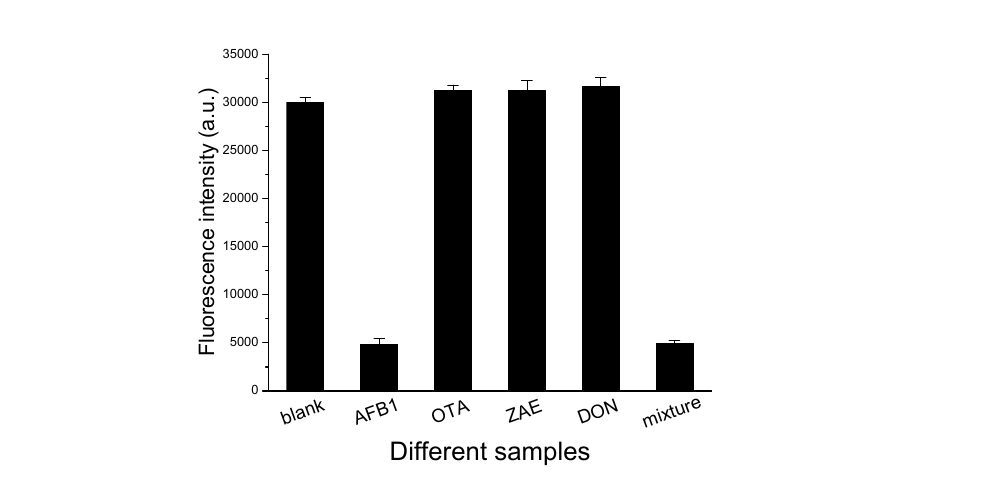
Figure 4. Fluorescence intensities corresponding to samples containing different mycotoxins. Assay buffer (pH 7.5) containing 20 mM Tris-HCl, 20 mM MgCl 2 , 200 mM NaCl and 0.1% ( v / v ) tween20 was used. Concentrations of MB probe and cDNA were 20 nM. AFB1 concentration was 500 nM. Concen- trations of OTA, ZAE and DON were 1 µ M. Excitation/emission was 485 nm/518 nm. Incubation was carried out at 4 °C for 20 min.